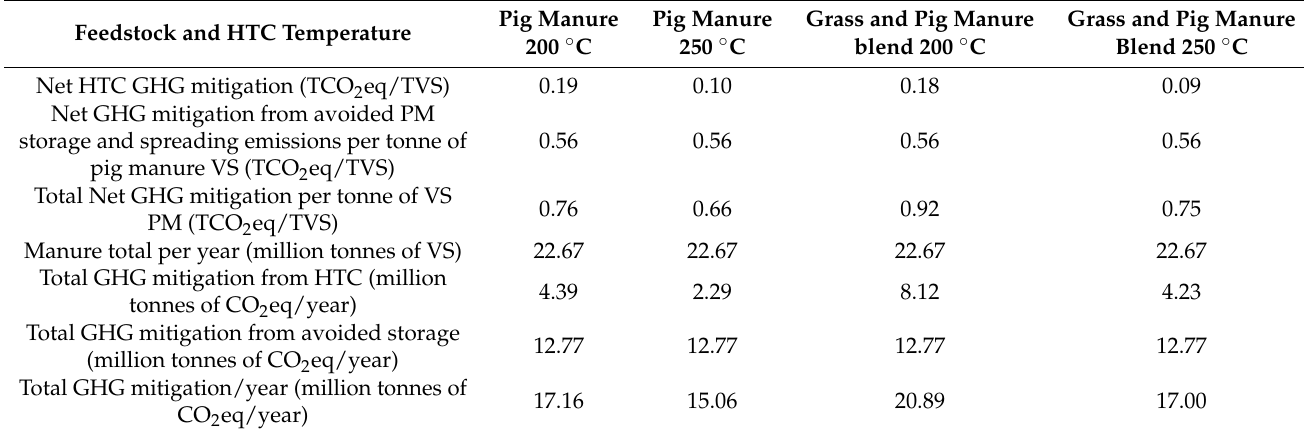
Table 4. EU GHG mitigation from HTC of PM and PM-grass